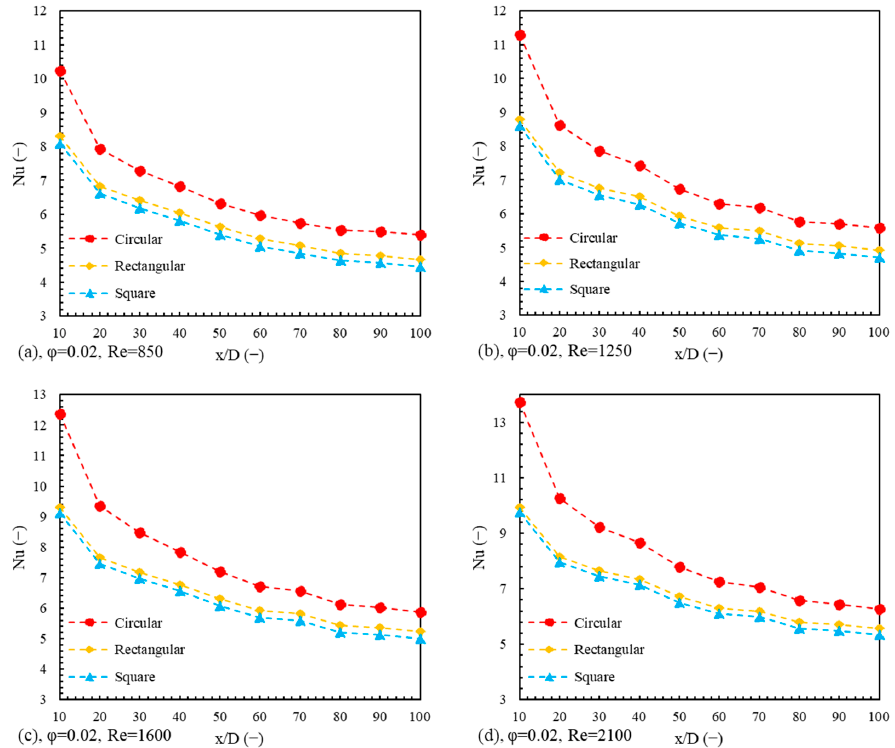
Figure 5. Local Nu of 2% nanofluid with different cross-sections in ( a ) Re = 850, ( b ) Re = 1250, ( c ) Re = 1600, and ( d ) Re = 2100. ( c ) Re = 1600, and ( d ) Re =